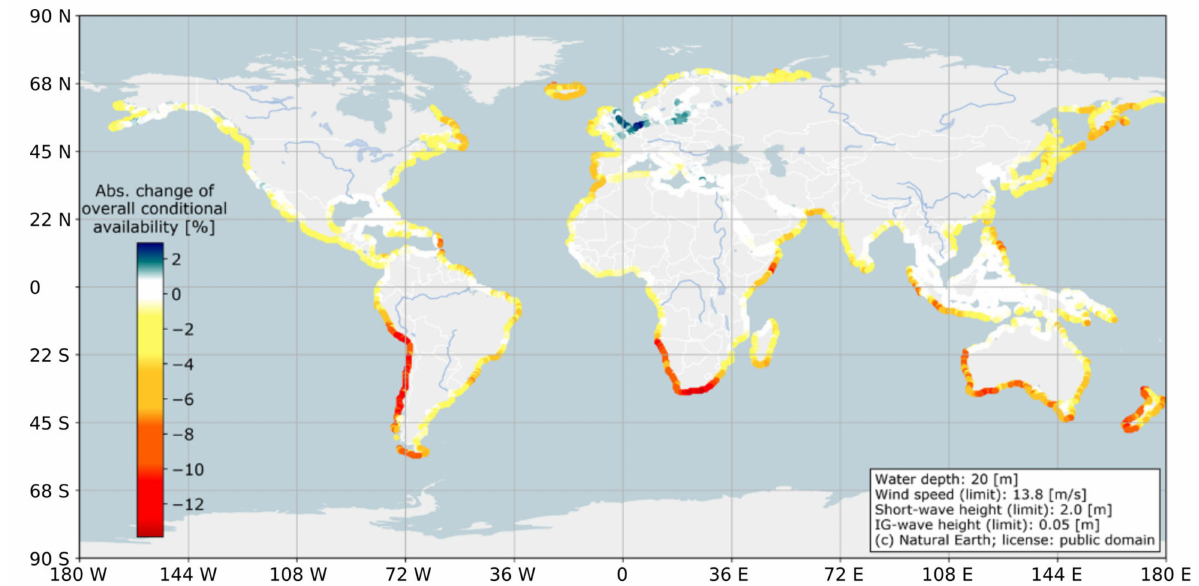
Figure 10. Geographical overview on the absolute change of overall conditional availability between 1979–2018. The dark red dots indicate locations where the risk levels change drastically negatively and the blue dots that change positively (dark blue). Input/thresholds used in the methodology are given in the lower right